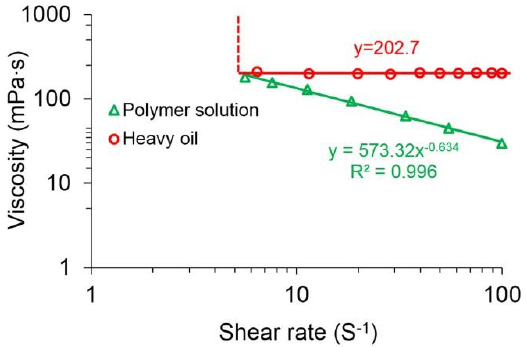
Figure 5. The viscosities of the polymer solution with a concentration of 2000 mg/L and the original heavy oil at different shear rates.